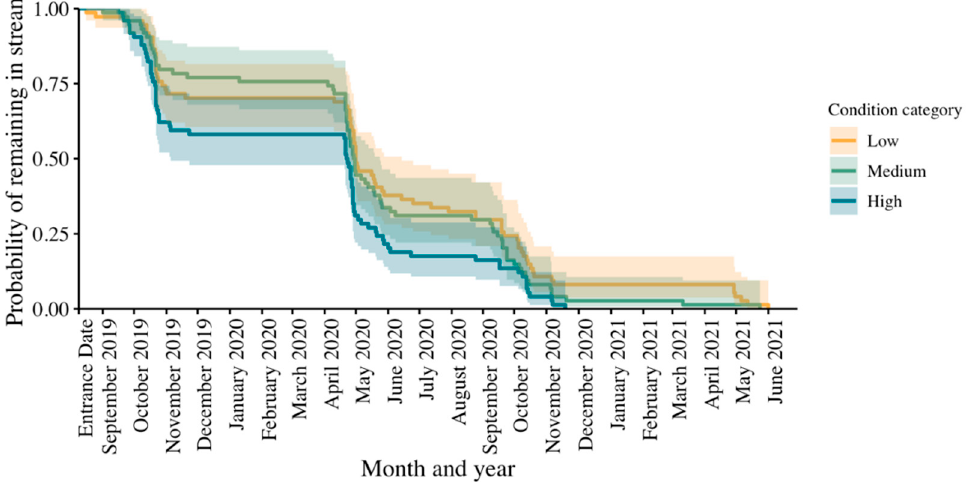
Figure 4. Probability of remaining in Graves Creek, Montana, for juvenile bull trout from the 2018 year-class, with colors delineating three condition categories based on the relative body condition at time of summer electrofishing, low (0.81–0.98, n = 74), medium (0.99–1.0, n = 74), high (1.1– 1.24, n = 74), and associated 95% confidence interval.